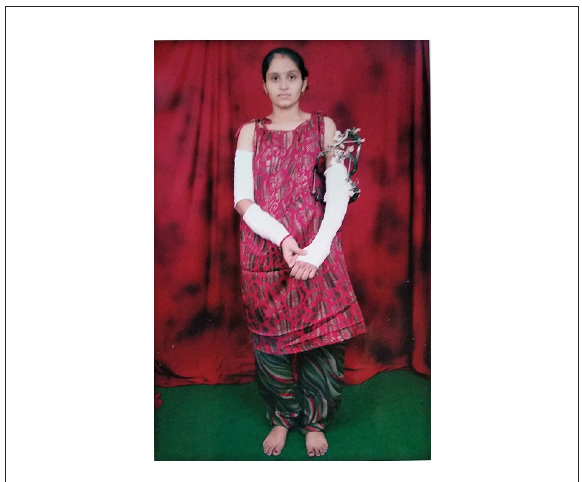
FIGURE1 Kalapn Rana during her treatment following a crocodile